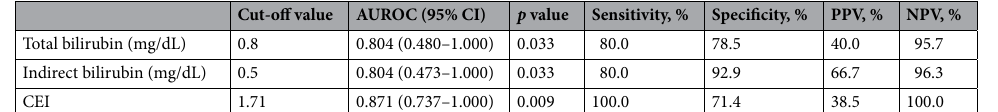
ROC curve analysis. As listed in Table 4, receiver operating characteristic (ROC) curve analysis revealed that total bilirubin ≥ 0.8 mg/dL and indirect bilirubin ≥ 0.5 mg/dL at baseline, and CEI ≤ 1.71 were the best cutoff values to predict the development of grade ≥ 2 hyperbilirubinemia. Specifically, the CEI was highly accurate in predicting hyperbilirubinemia (AUROC 0.871, 95% CI 0.737–1.000, p = 0.009, sensitivity 100%, specificity 71.4%, positive predictive value 38.5% and negative predictive value 100%). Multivariate analysis factors associated with development of grade ≥ 2 hyperbilirubine‑ mia. As shown in Table 5, univariate and multivariate logistic regression analyses of baseline factors related